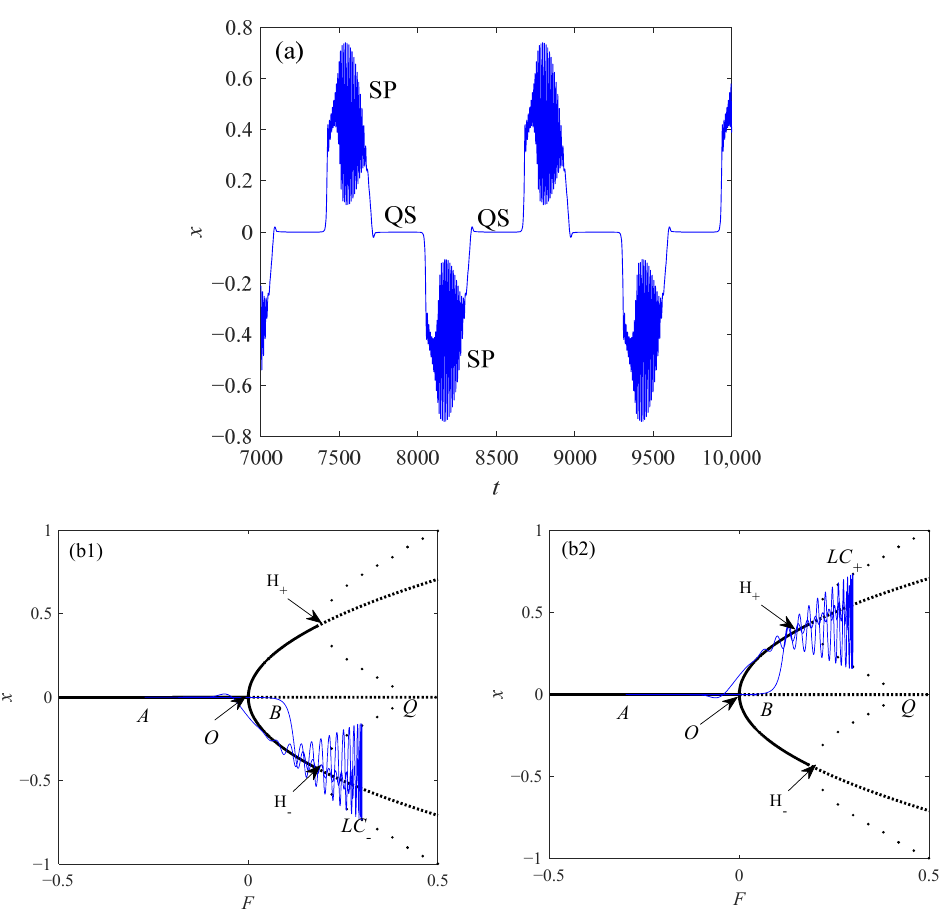
Figure 9. Cluster oscillation with β = 0.3. ( a ) Time history diagram. ( b1 ) Superposition of the transition phase diagram and bifurcation diagram on ( F , x ) plane for the lower branch. ( b2 ) Superposition of the transition phase diagram and bifurcation diagram on ( F , x ) plane for the upper branch.